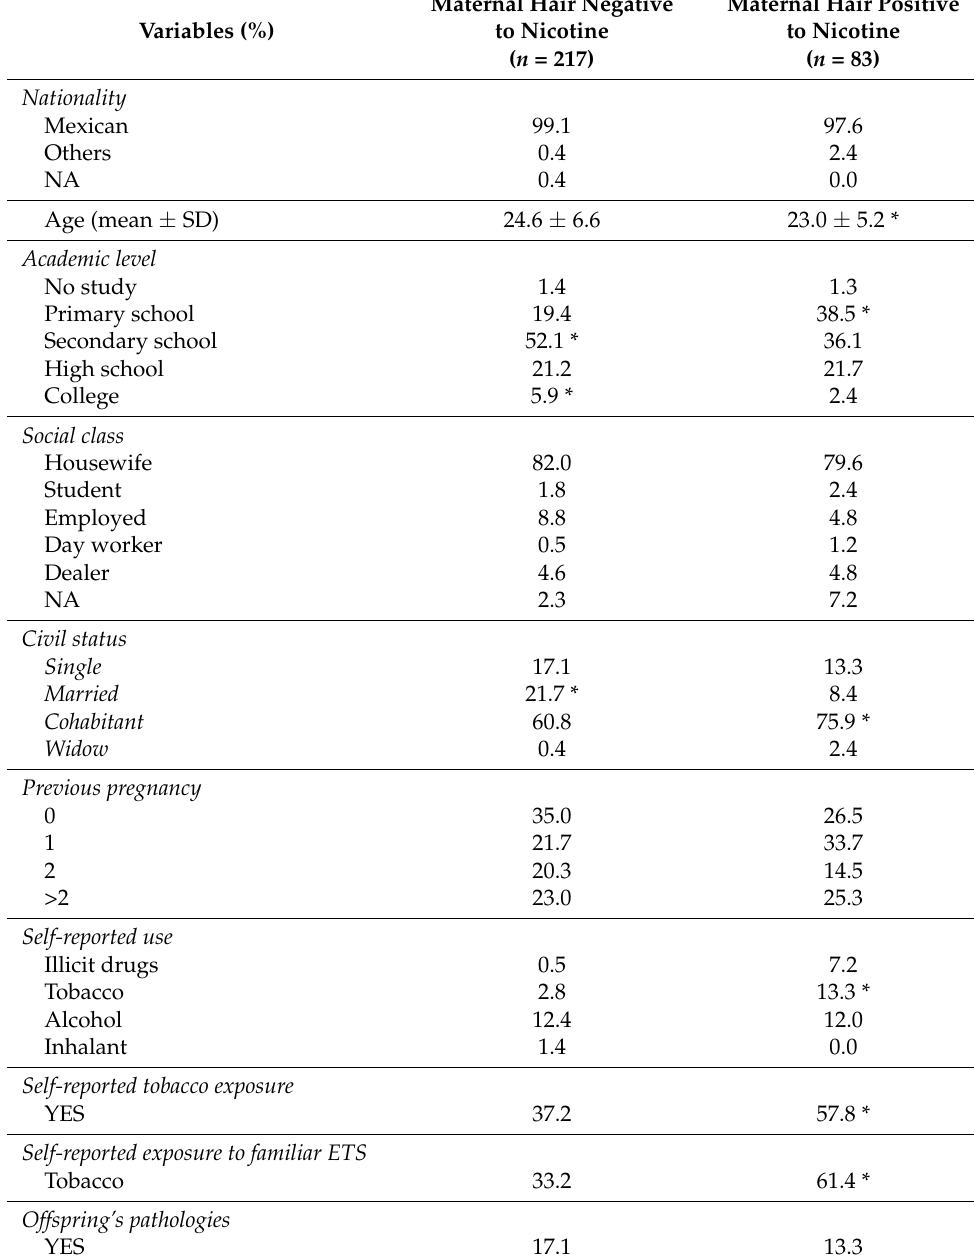
Table 5. Sociodemographic profiles associated with gestational exposure to tobacco smoke assessed by hair testing. Variables (%)